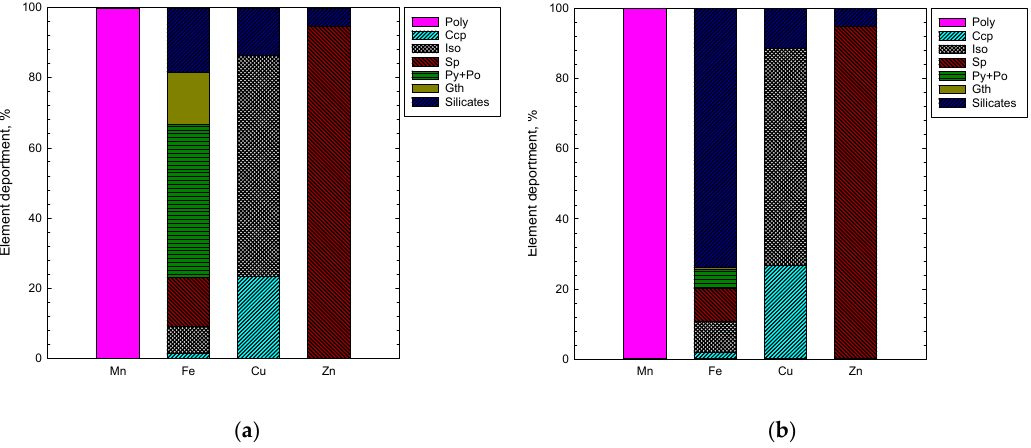
Figure 7. Mn, Fe, Cu and Zn deportment (calculated by automated mineralogy) in ( a ) feed (PN (67%) and SMS (33%)), and ( b ) leaching residue after 48 h. Abbreviations after [23]: Ccp—chalcopyrite, Sp—sphalerite, Py—pyrite, Po—pyrrhotite, Gth—goethite. Poly is heterogeneous layer growth structure of nodules, Iso is isocubanite.